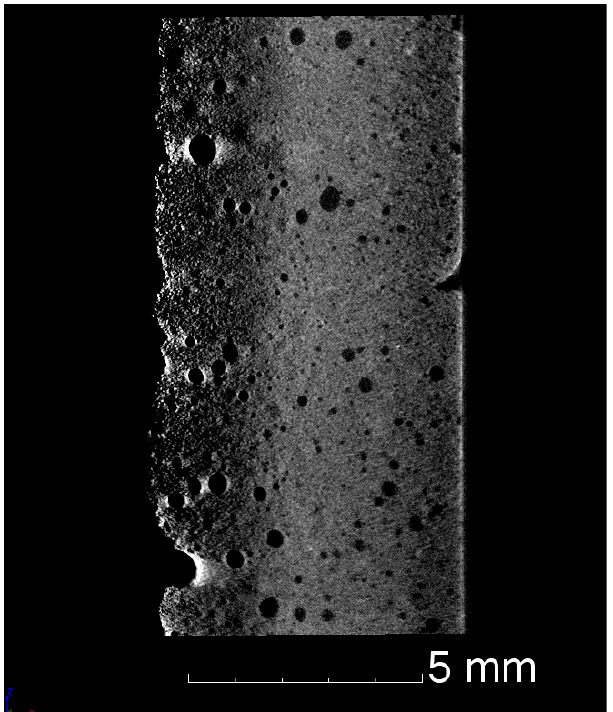
Figure 5. CT image of the fine-grained composite showing inhomogeneously distributed pores with a diameter larger than